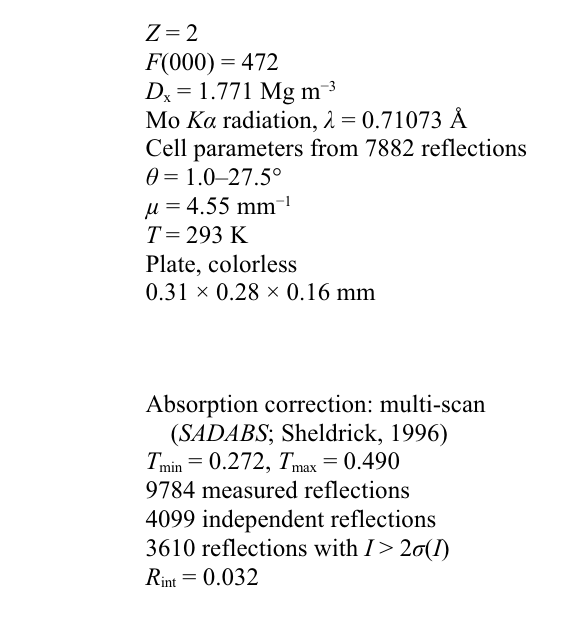
Projection of a molecule of (IV), showing the atom labelling with 50% probability displacement ellipsoids. 3-(2,4-Dibromoanilino)-2,2-dimethyl-2,3-dihydronaphtho[1,2- b ]furan- 4,5-dione Crystal